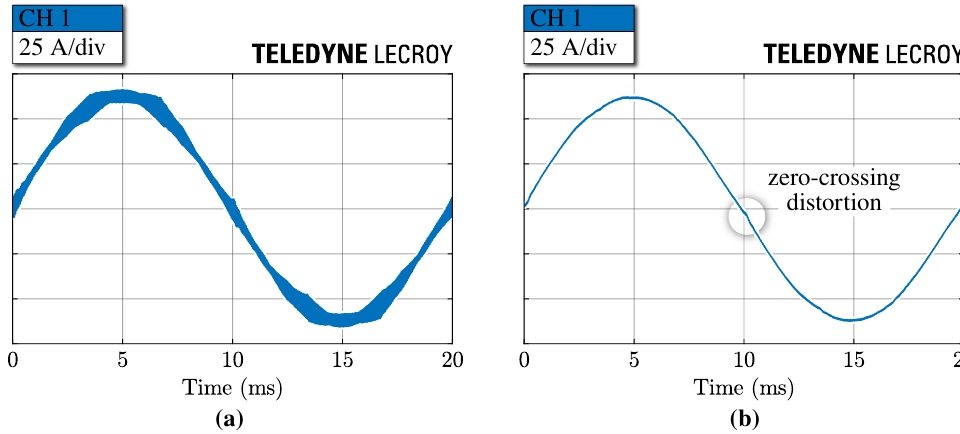
Figure 16. Experimental converter-side current i ( a ) and filtered grid-side current i f ( b ) at I = 61.5A and V dc = 800V. Zero mid-point current modulation (ZMPCPWM) is adopted [20].